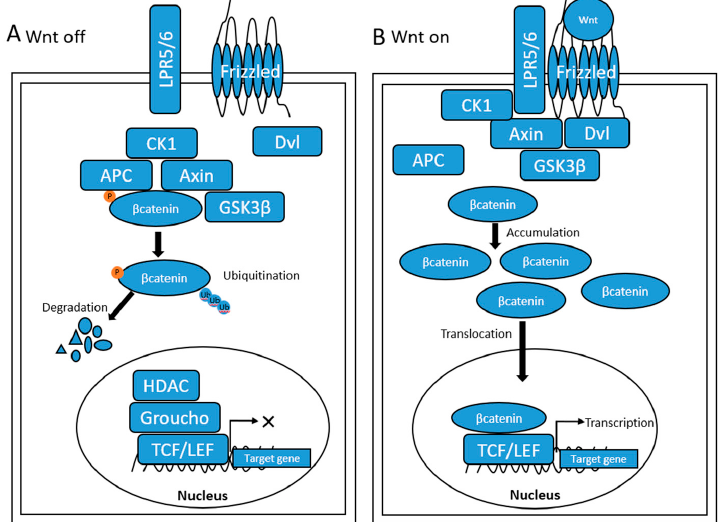
Figure 1. Canonical Wnt signaling pathway. ( A ) Wnt o ff . When Wnt is not bound to the frizzled/lip- oprotein receptor-related protein (LRP) coreceptor complex, Wnt/ β -catenin signaling is inactive. The destruction complex can then phosphorylate β -catenin, which leads to β -catenin ubiquitination and corresponding proteasomal degradation. In the nucleus, the binding of Groucho to T-cell factor (TCF) inhibits the transcription of Wnt target genes. ( B ) Wnt on. Binding of the WNT ligand to the frizzled-LRP5/6 coreceptor recruits disheveled (Dvl) and Axin to disrupt the destruction complex. This then causes the accumulation of β -catenin, which translocates into the nucleus. β -catenin then binds to TCF/lymphoid enhancer factor (LEF) in the nucleus and activates the transcription of Wnt target genes.